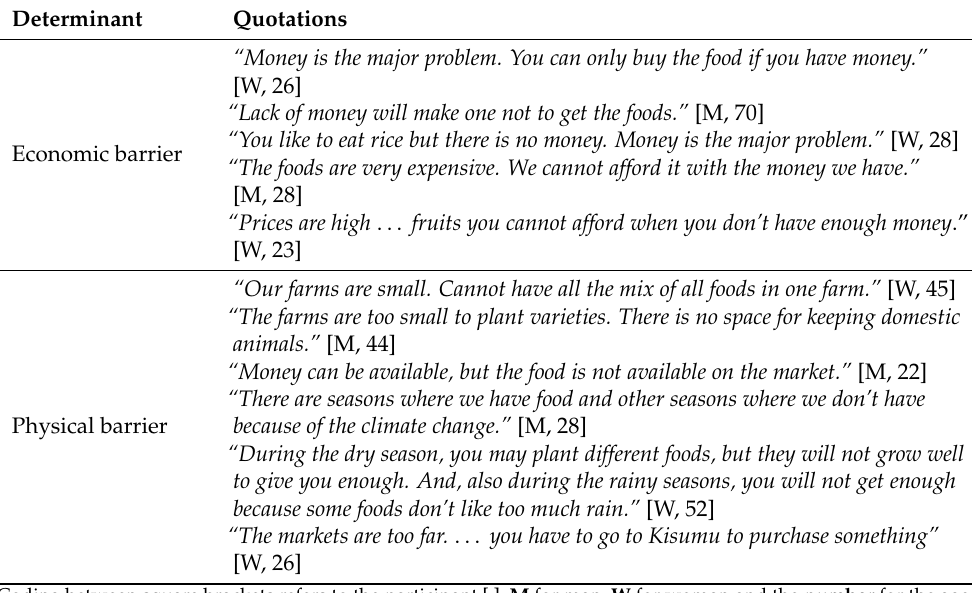
Table 5. Environmental determinants of healthy eating and quotations from participants of Focus Group Discussions in Vihiga County,